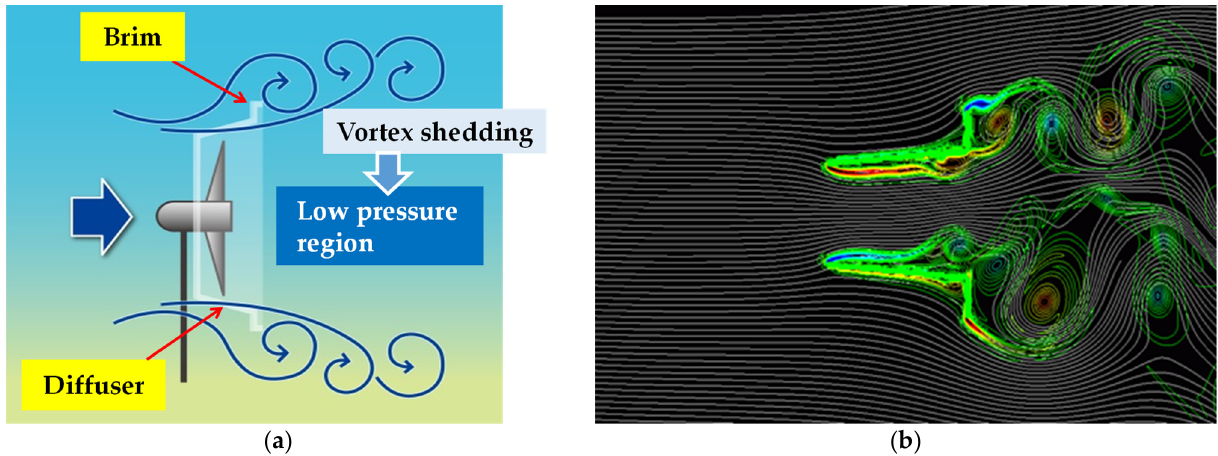
Figure 1. ( a ) Mechanism of wind lens technology. Adapted from ref. [20]; ( b ) two-dimensional flow around a wind lens using computational fluid dynamics (CFD). The white lines show streamlines, and flow is accelerated where the lines are closely spaced. The multi-colored lines are vorticity contours, where blue represents clockwise vorticity and red represents counterclockwise vorticity.